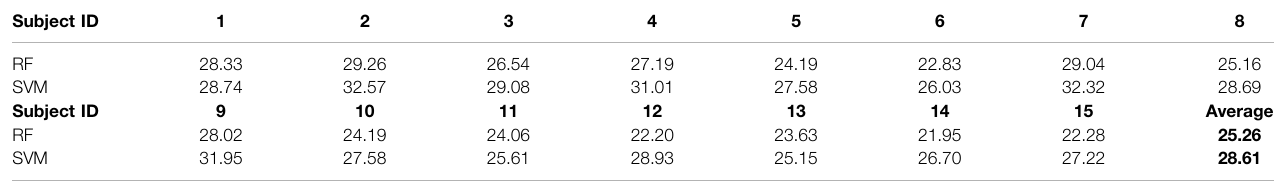
TABLE 4 | Subject-wise classi fi cation accuracy obtained for proposed imagined word dataset. The chance level of classi fi cation is 16.6% (six classes).